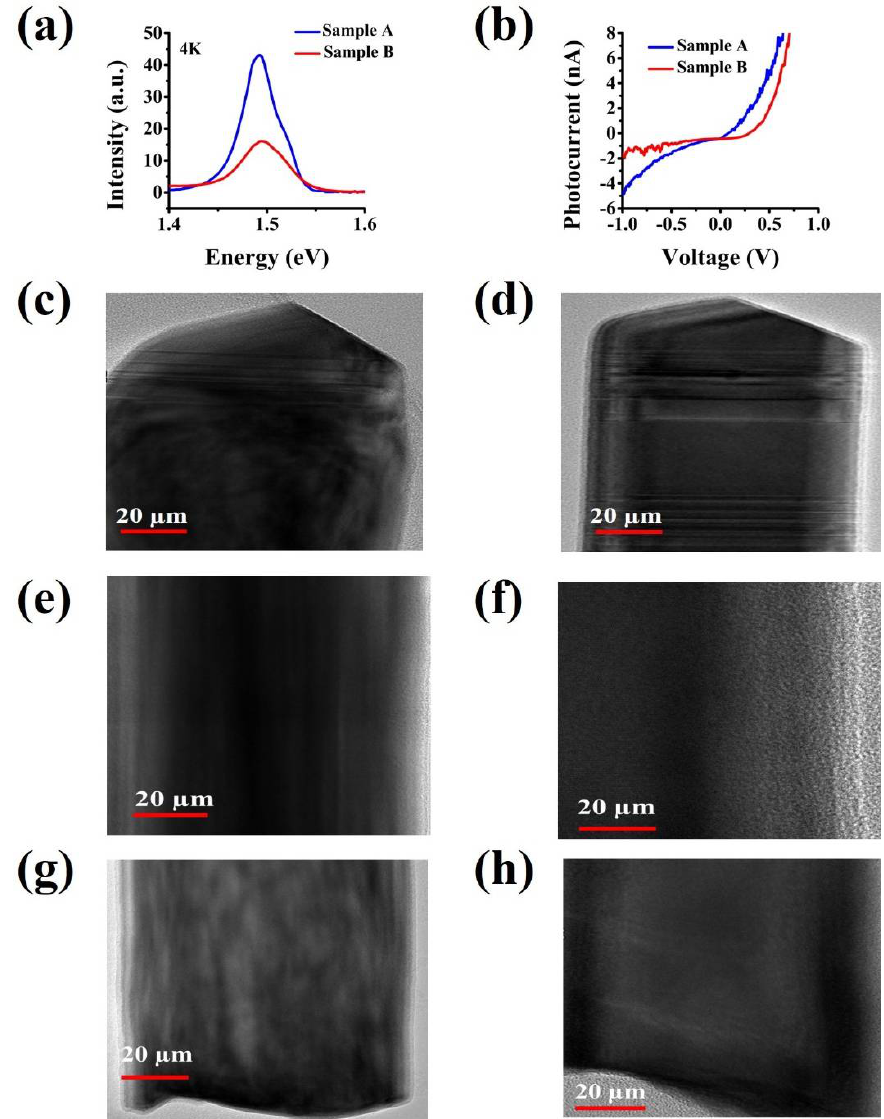
Figure 1. ( a ) Superimposed 4K PL spectra, ( b ) superimposed SNW I-V characteristics under illumina- tion, ( c , e , g ) and ( d , f , h ) HRTEM images of NW top, middle, and bottom segment of Te-doped GaAs NWs with two different droplet consumption